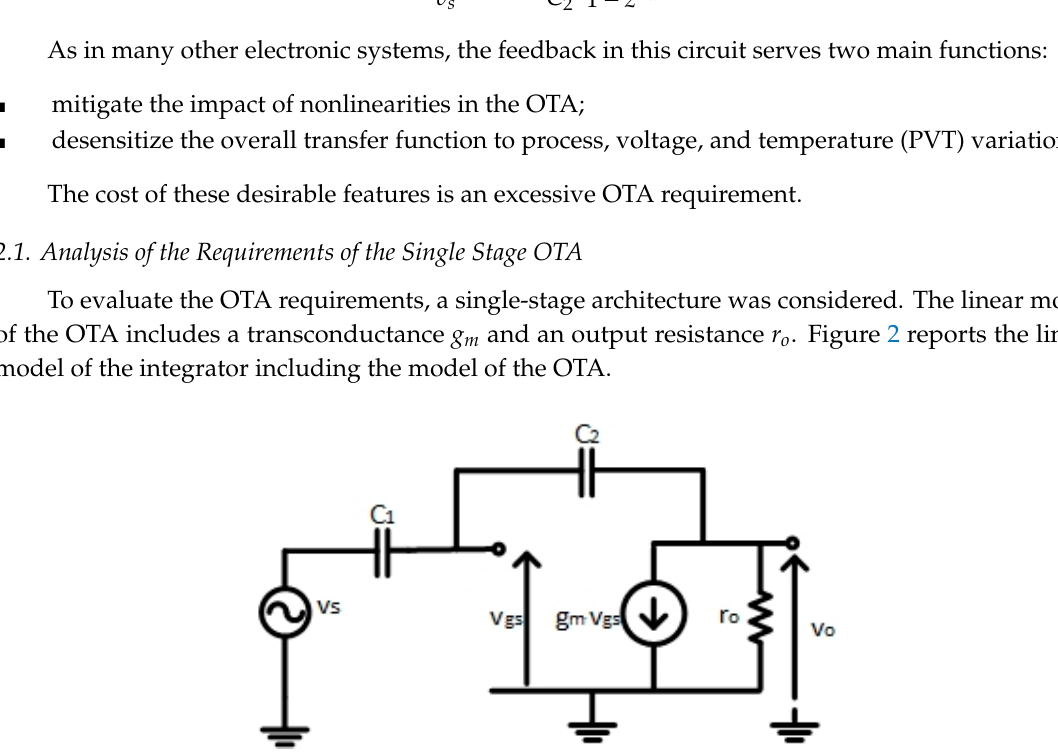
Figure 2. Equivalent small-signal circuit of the closed-loop switched-capacitor integrator with a single-stage operational transconductance amplifier (OTA).